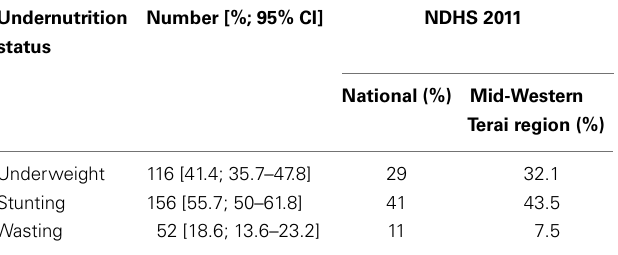
Table 4 | Undernutrition status of children ( n = 280)